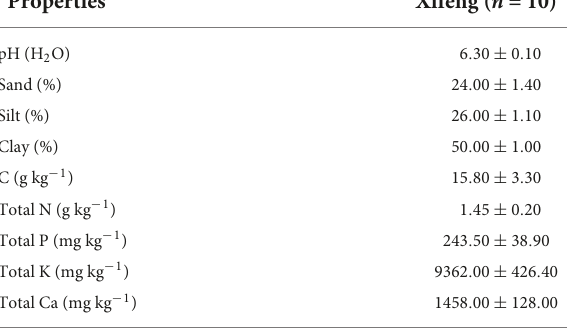
TABLE 1 Soil physico-chemical characteristics in the Xifeng